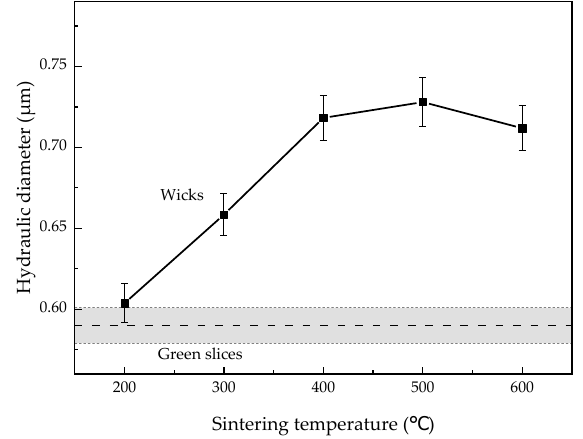
Figure 6. Mean pore diameter of green slices and wicks sintered at different temperatures.